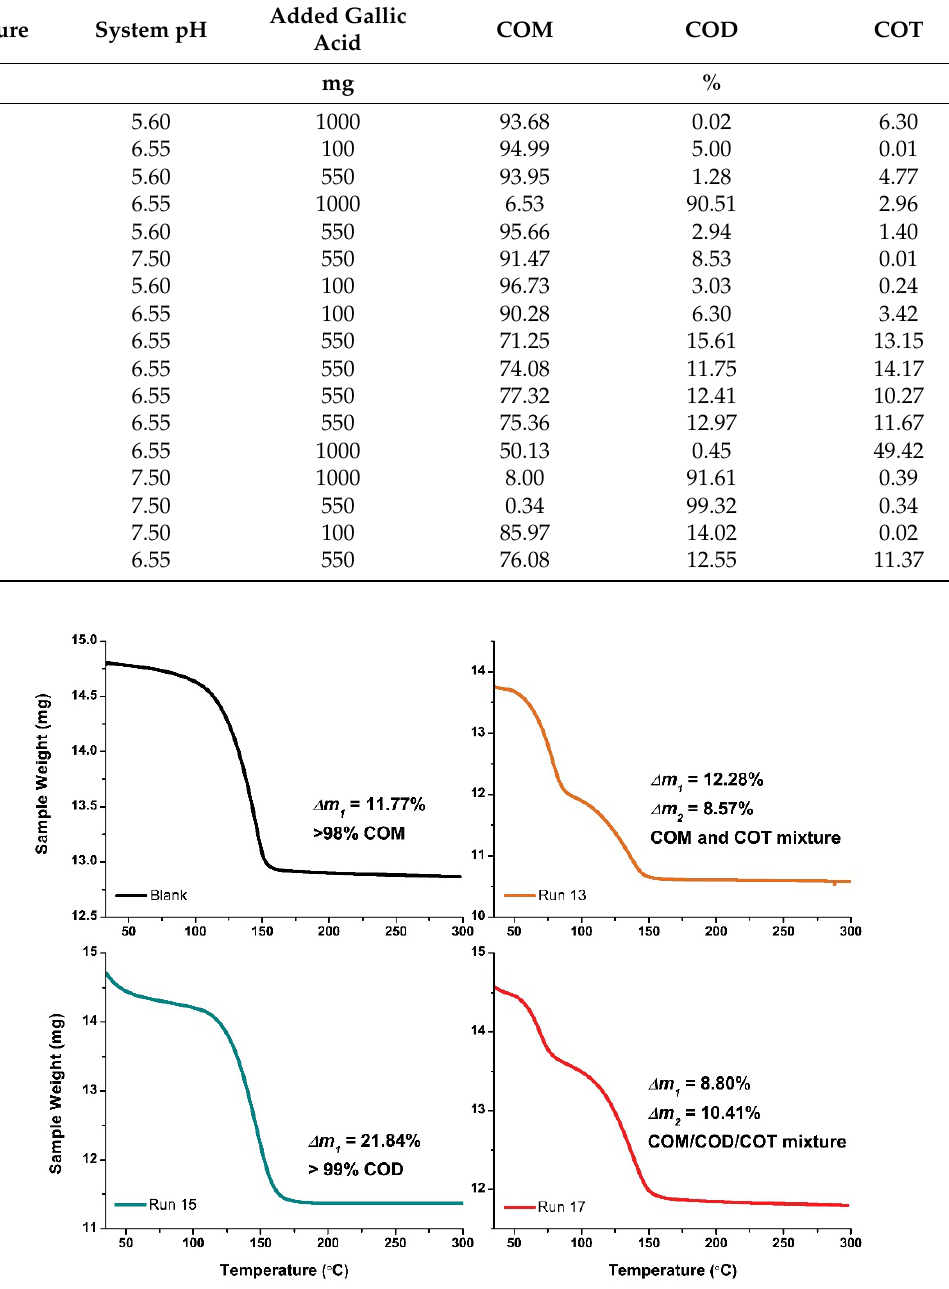
Figure 1. Thermal curves of calcium oxalate samples.